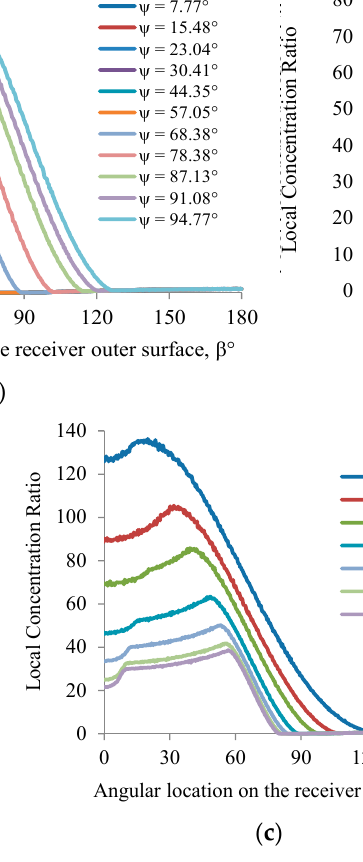
22.8 In the table: LS2 = Luz Solar 2 collector, sun = unit of light concentration = 1 kW/m 2 ; C min , C max and C avg , and MAD stand for minimum, maximum and average light concentration, and Mean Absolute